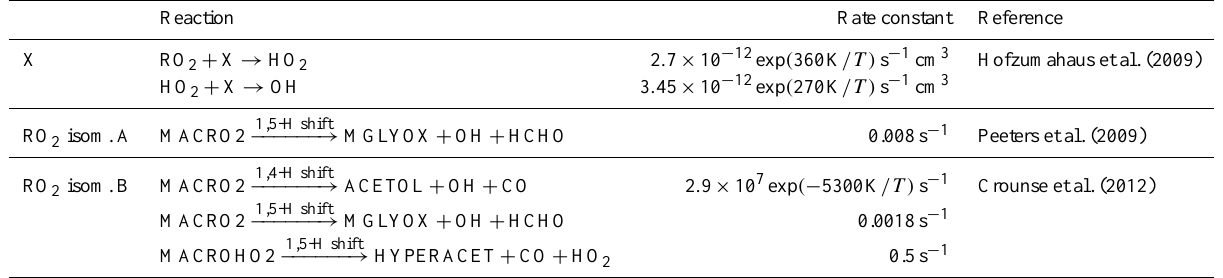
Table 4. Modification of MCM oxidation scheme for MACR. The “X” mechanism adds generic recycling of OH via reaction of peroxy radicals with a compound, X, which behaves like NO. The two cases of RO 2 isomerization produces additional OH via RO 2 isomerization with subsequent decomposition of the